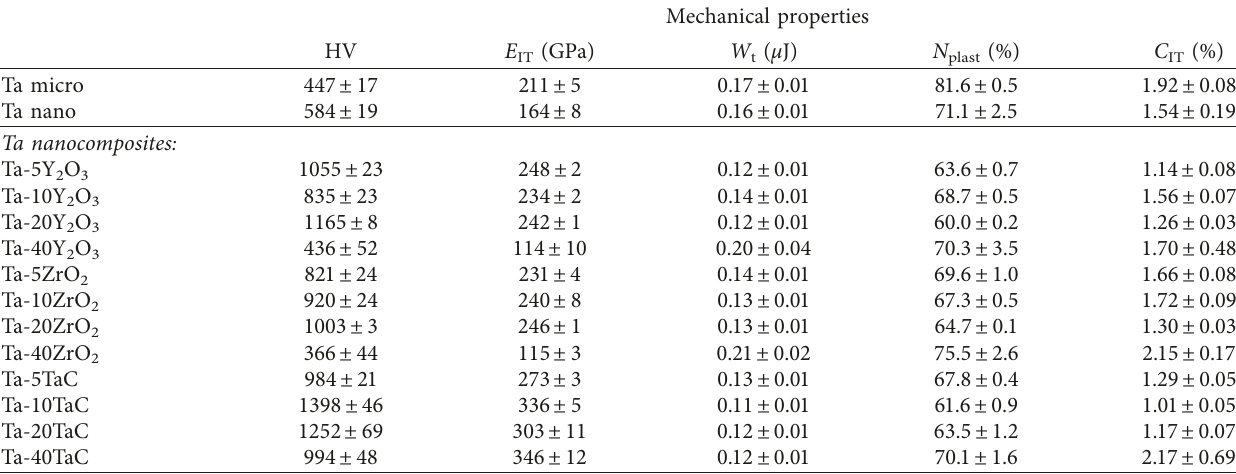
Table 1: Mechanical properties of the investigated hot-pressed Ta-ceramic nanocomposites (data for micro- and nanocrystalline Ta for